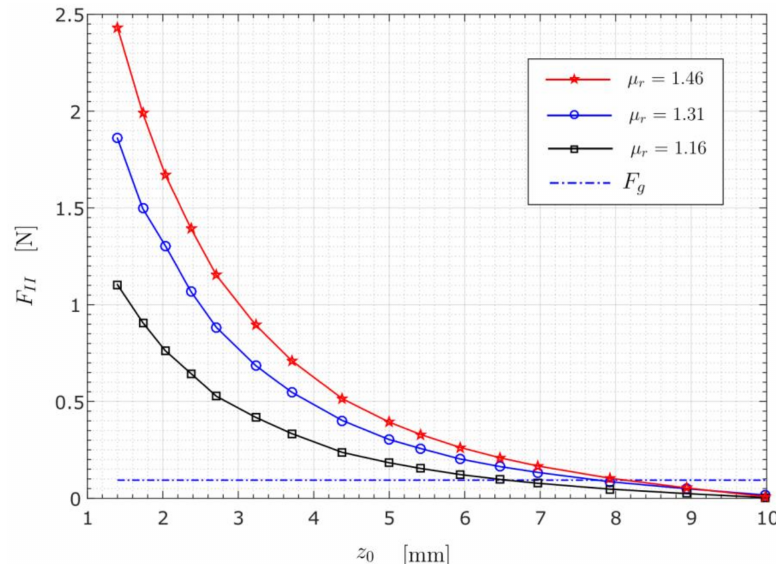
Figure 16. The calculated curves of magnetic levitation force F II for three different values of MF’s permeability, i.e., µ r = 1.16, µ r = 1.31, and µ r = 1.46, respectively. The force F II was calculated by the SIM. The stable levitation height z 0 appears where the individual curve F II intersects the gravitational force line F g